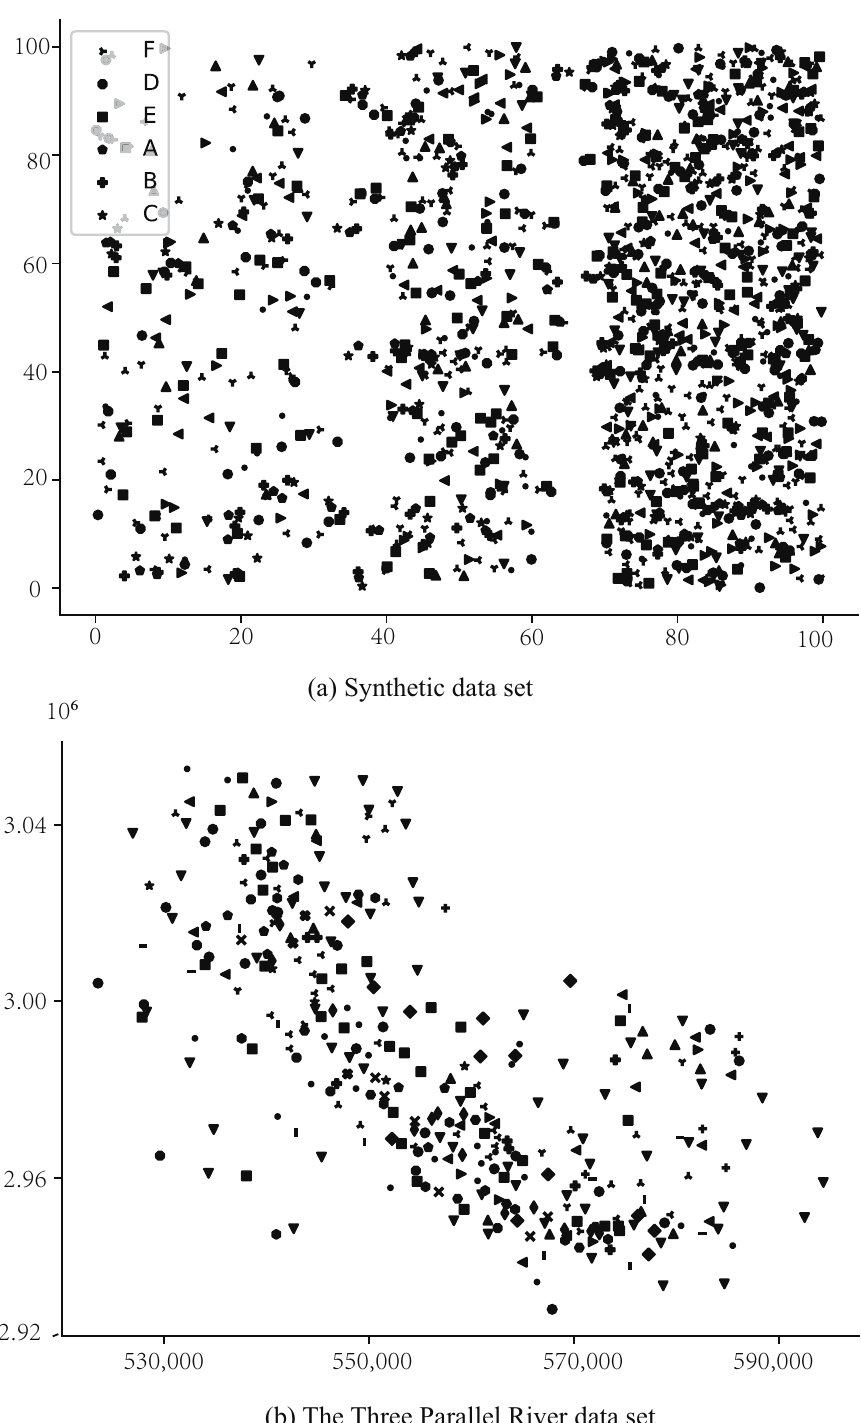
Figure 4. These are the distributions of the Synthetic data set and the Three Parallel Rivers data set. ( a ) A, B, and C are highly correlated to each other in all of the three density areas, and so are D, E, and F. ( b ) Different densities are distributed in the data sets. The default unit of distance metrics is meters in Figure 4a,b in addition to all distance thresholds in this